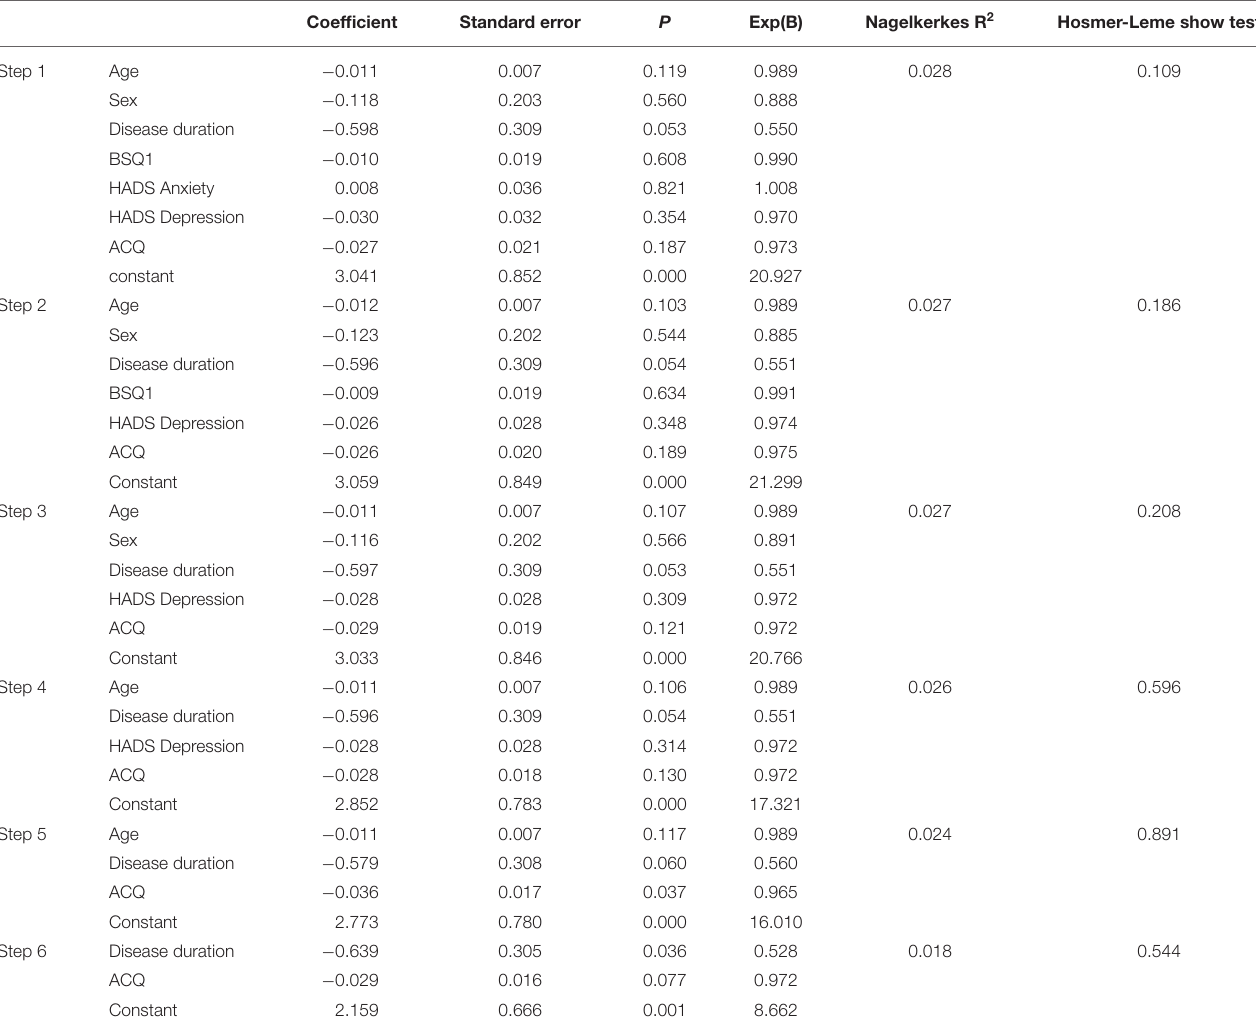
TABLE 5 | Binominal logistic regression: dependent variable consultation of somatic- ( = 1) or psychologically ( = 0) oriented healthcare provider (backward selection).